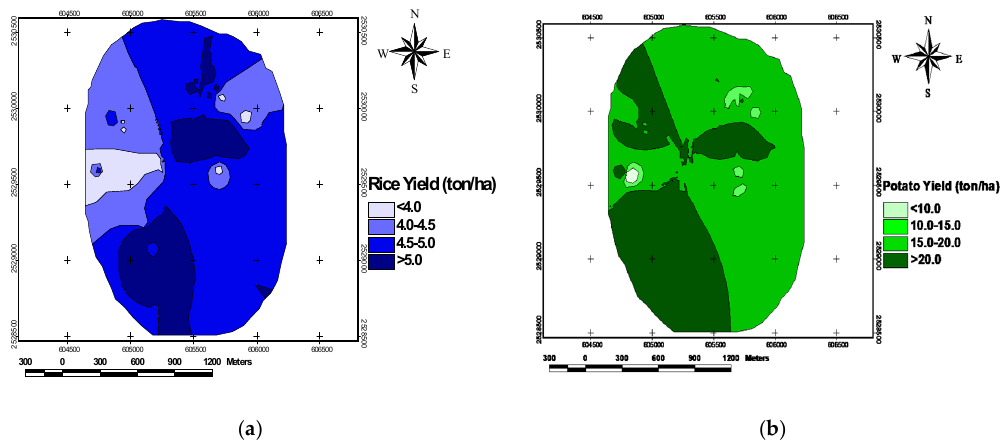
Figure 6. Yield distribution map of study area; ( a ) rice crop, ( b ) potato crop.